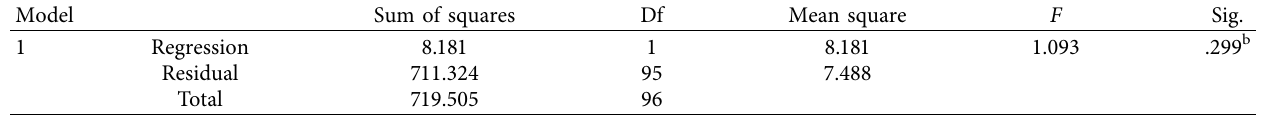
Table 9: Analysis of variance (ANOVA) results for agricultural teaching approaches and food security. Model